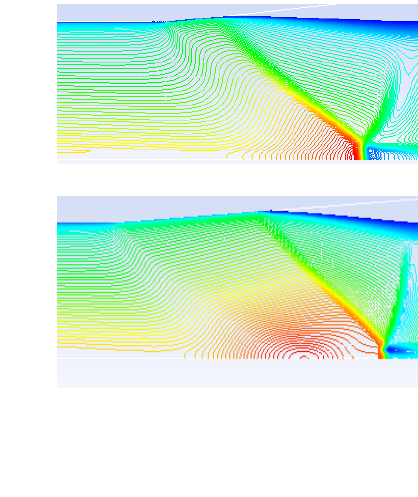
Fig. 6. Mach contours of pressure-based (upper) and density-based solver